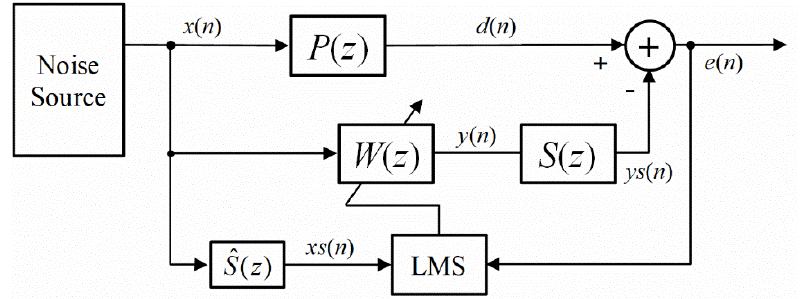
Figure 1. Block diagram of conventional filtered least-mean-square (FxLMS) algorithm based on feedforward active noise cancellation (ANC) systems.